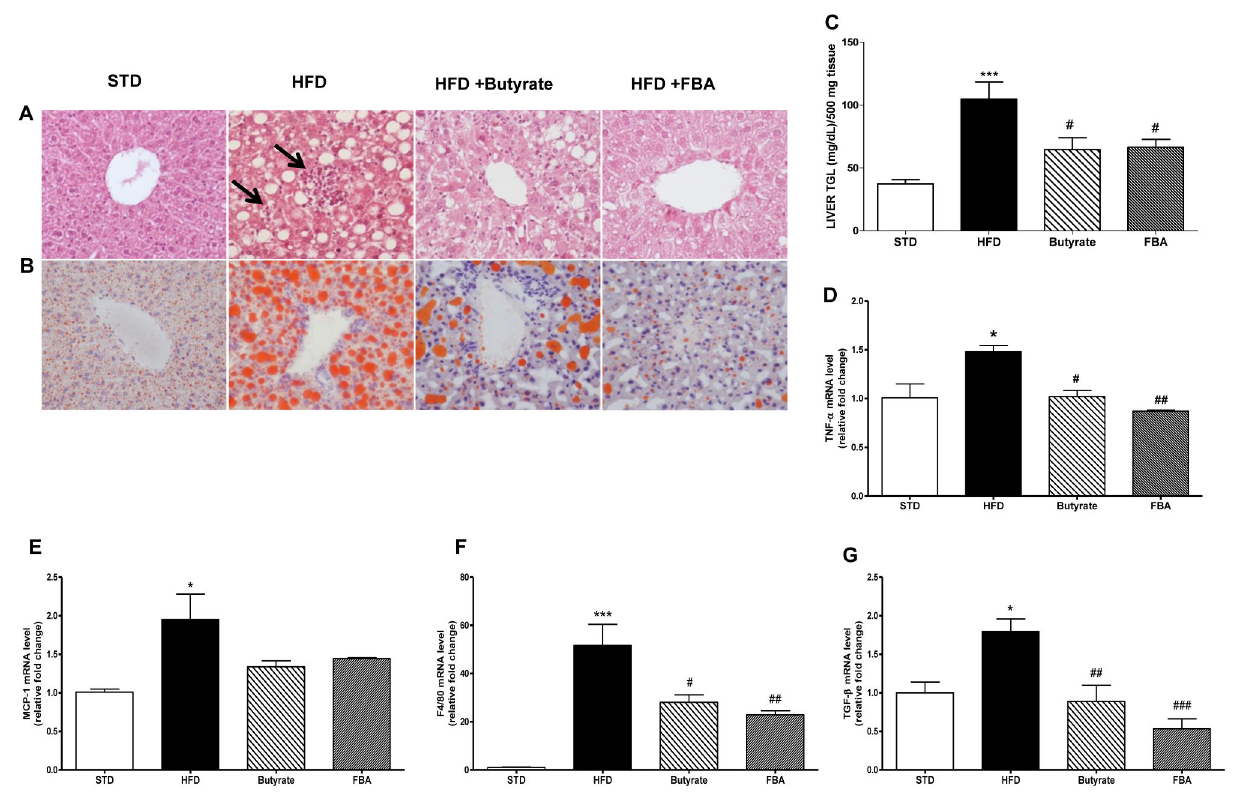
Figure 1. Effects of butyrate and FBA on liver steatosis. Paraffin-embedded sections of the liver (n=4 each group) were stained with hematoxylin-eosin (A) or oil red O (B). Micrographs in both panels are representative pictures with original magnification 40X. Foci of inflammatory cells are shown (arrows). (C) Triglycerides were measured in liver and normalized on 500 mg of frozen tissue (n=6 each group). The mRNA levels of pro-inflammatory cytokines TNF-α (D), MCP-1 (E), F4/80 (F), and TGF-β (G) were analyzed by real-time PCR in liver extracts (n=6, each group). *P<0.05, ***P<0.001 vs STD; # P<0.05, # # P<0.01, # # # P<0.001 vs HFD. doi: